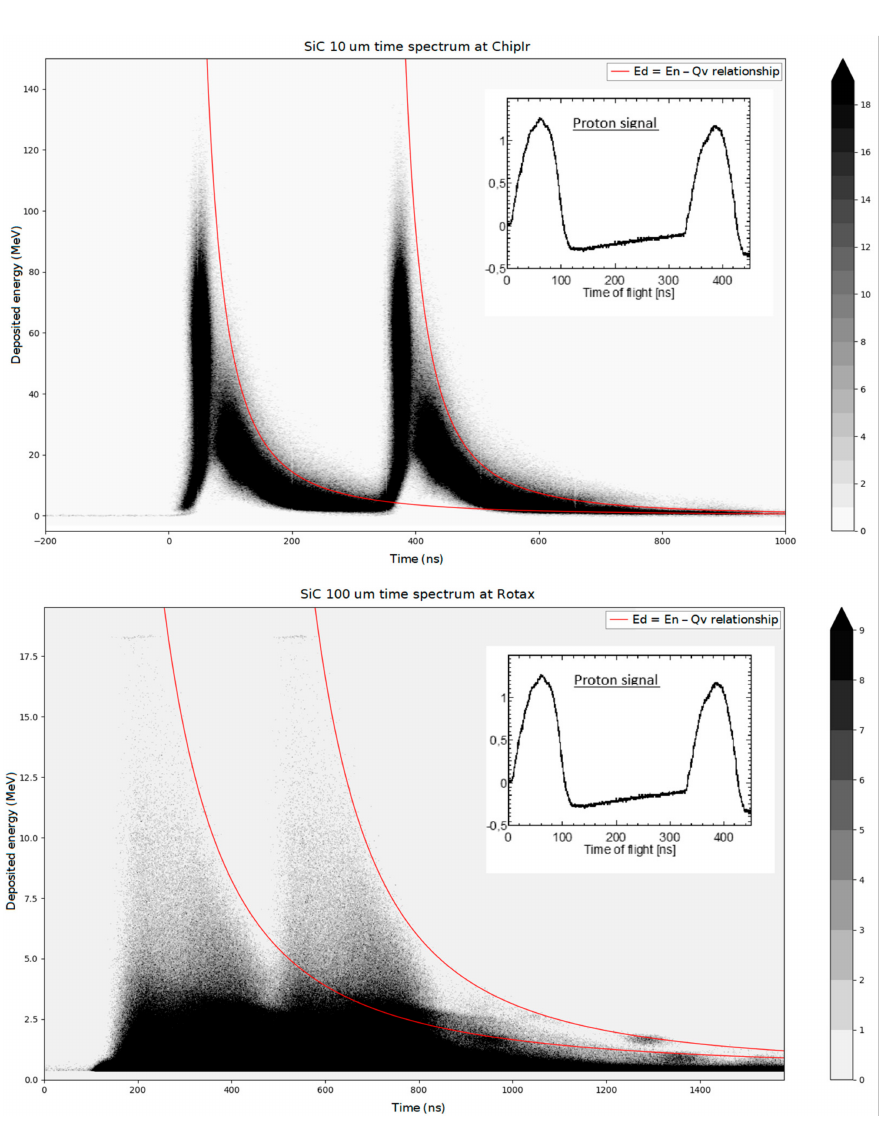
Figure 4. Event density plot (in the time of flight (ToF) vs. E d space) of 100 µ m SiC on ROTAX (top) and of 10 µ m SiC on ChipIr (bottom). The two-bunch Proton Synchrotron (PS) spectrum is showcased on the right. The red lines represent the relationship between ToF and E n and are separated by 322 ns, mirroring the PS spectrum.